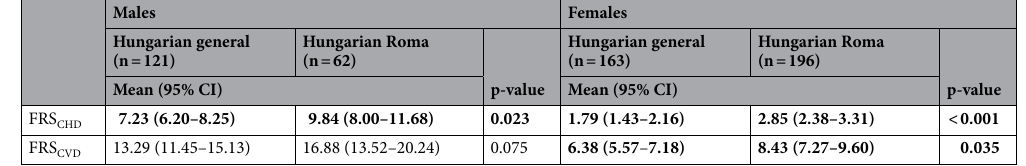
Table 4. Results obtained by Framingham Risk Score for hard coronary heart disease (FRS CHD ) and Framingham Risk Score for cardiovascular disease (FRS CVD ) calculations in the 30–64-year-old Hungarian general and Hungarian Roma populations. Significant differences in mean or prevalence rates are highlighted in